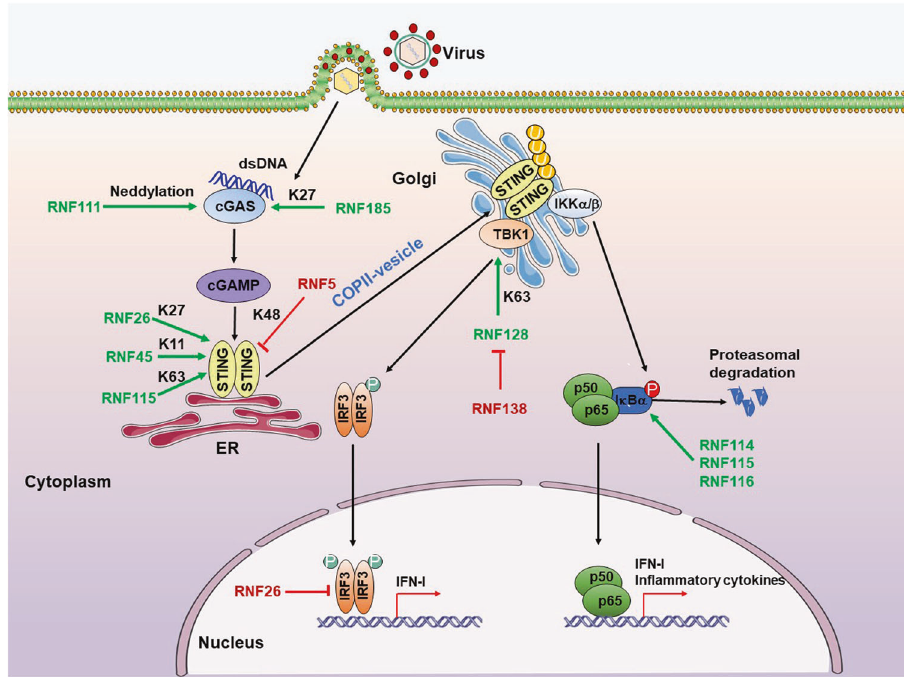
Fig. 4 RNF proteins orchestrate the cGAS-STING signaling pathway. Upon activation by dsDNA, cytosolic cGAS triggers STING activation and translocation through synthesizing cGAMP, consequently inducing IFN-I and in fl ammatory cytokines production. RNF proteins can target multiple steps in the DNA sensing signal pathway. Overview of the RNF proteins that positively (green arrows) or negatively (red T-shaped solid line) cGAS-STING signaling. P, phosphate; U,